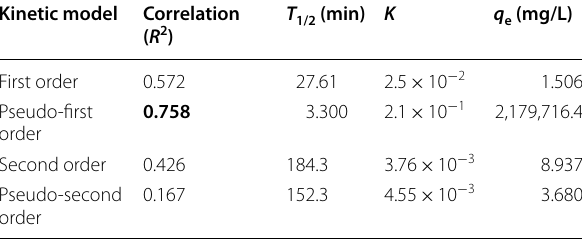
The correlation coefficient value in bold indicated the highest correlation value and the most predominant order of the reaction R 2 Correlation coefficient, T 1/2 reaction half-life, K rate constant in different = = = units (first and pseudo-first order in min − 1 and second and pseudo-second order